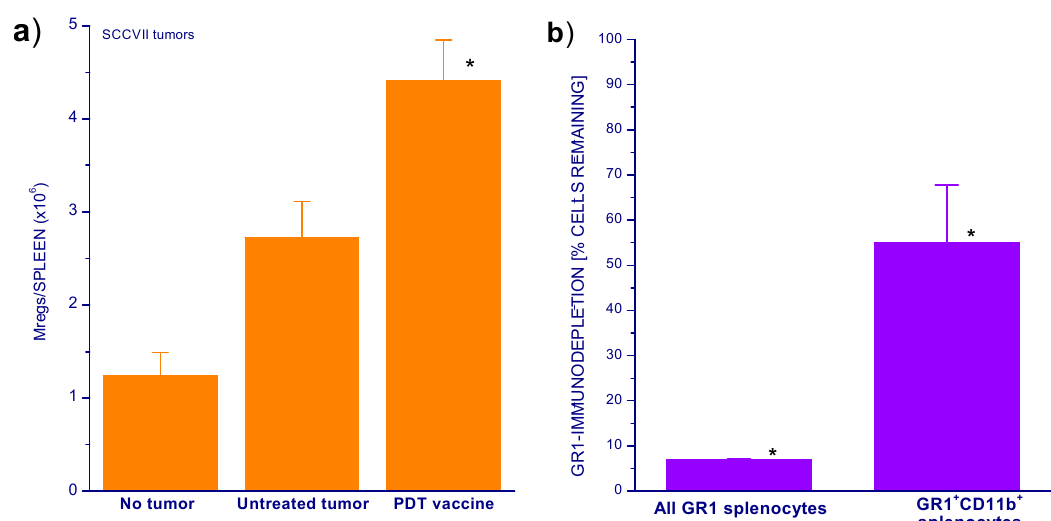
Figure 2. Spleen Mreg levels in untreated and PDT vaccine treated mice and the impact of anti-GR1 mediated immunodepletion. ( a ) Spleens were collected 72 h after PDT vaccine treatment (SCCVII cells treated with ce6-PDT, post-incubated 16 h, and injected at 2 × 10 7 /mice as described in Experimental Section). Splenocytes from these spleens and from control untreated mice were stained for GR1 and CD11b markers for determining granulocytic Mreg levels by flow cytometry; ( b ) mice were injected i.v. with anti-GR1 antibody (0.1 mg per mouse) and sacrificed 24 h later for determining the numbers of remaining GR1-positive splenocytes and granulocytic Mregs (GR1 + CD11b + ) by antibody staining followed by flow cytometry. n = 4, bars are SD. * Statistically significant difference ( p < 0.05) from control groups or pre-treatment levels.